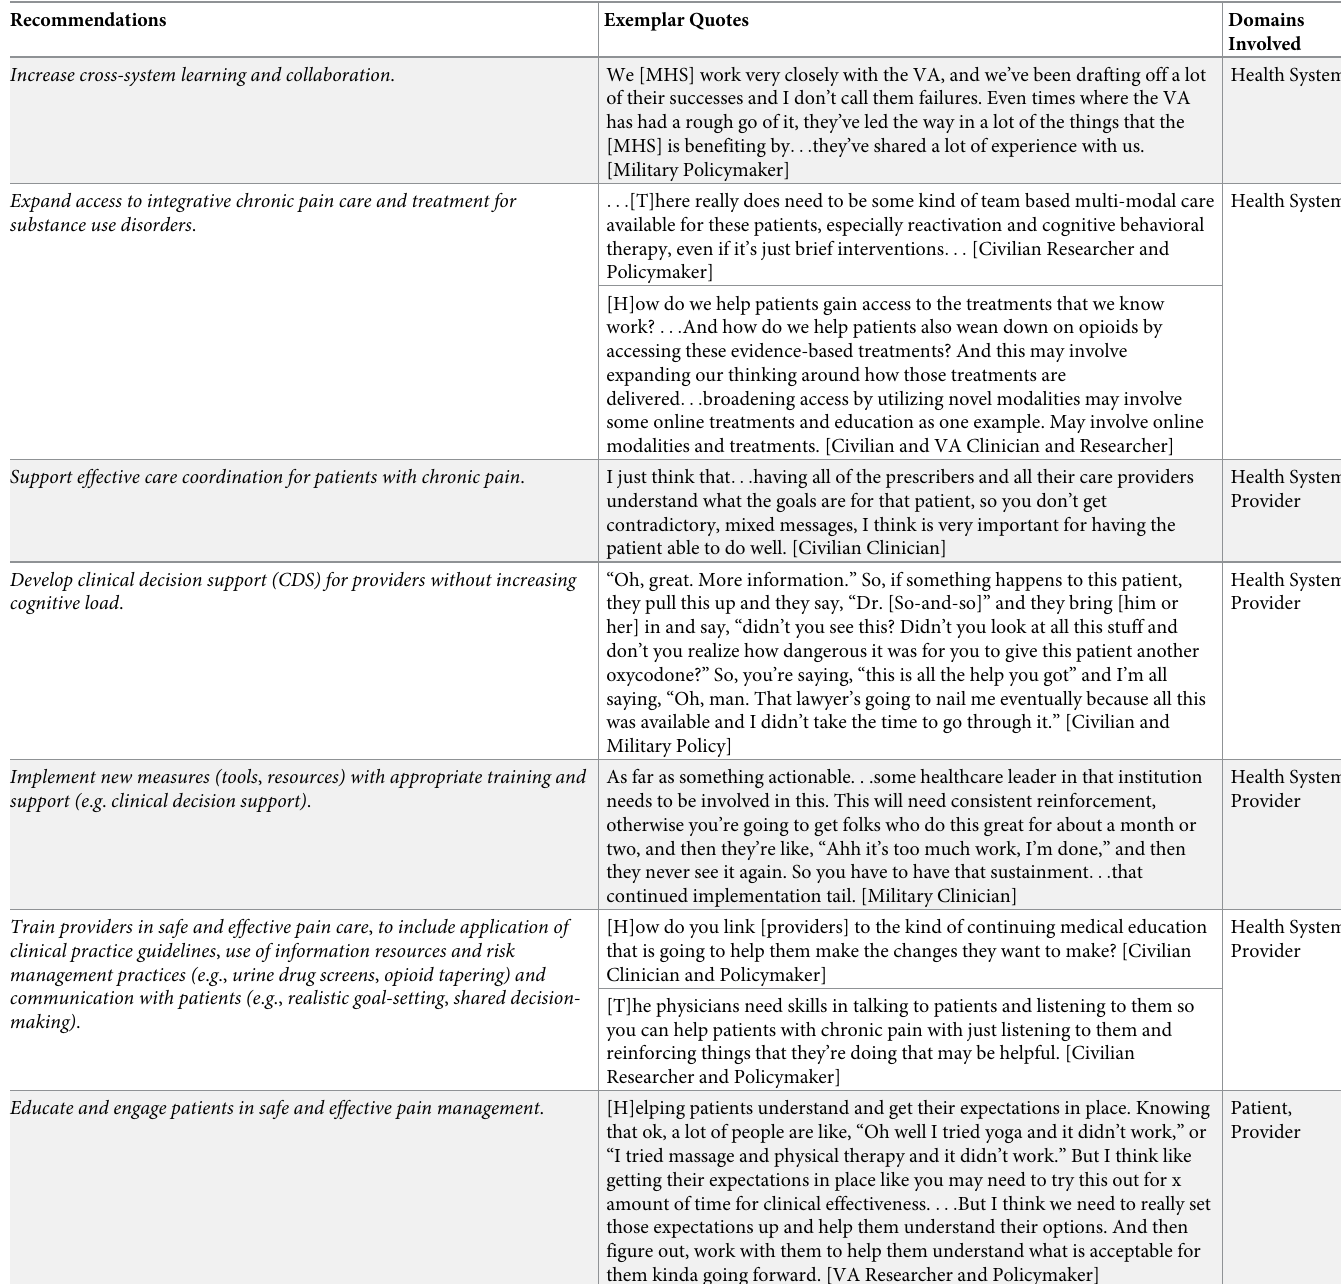
Table 3. Recommendations for achieving safe and effective chronic pain management and opioid risk mitigation identified by expert